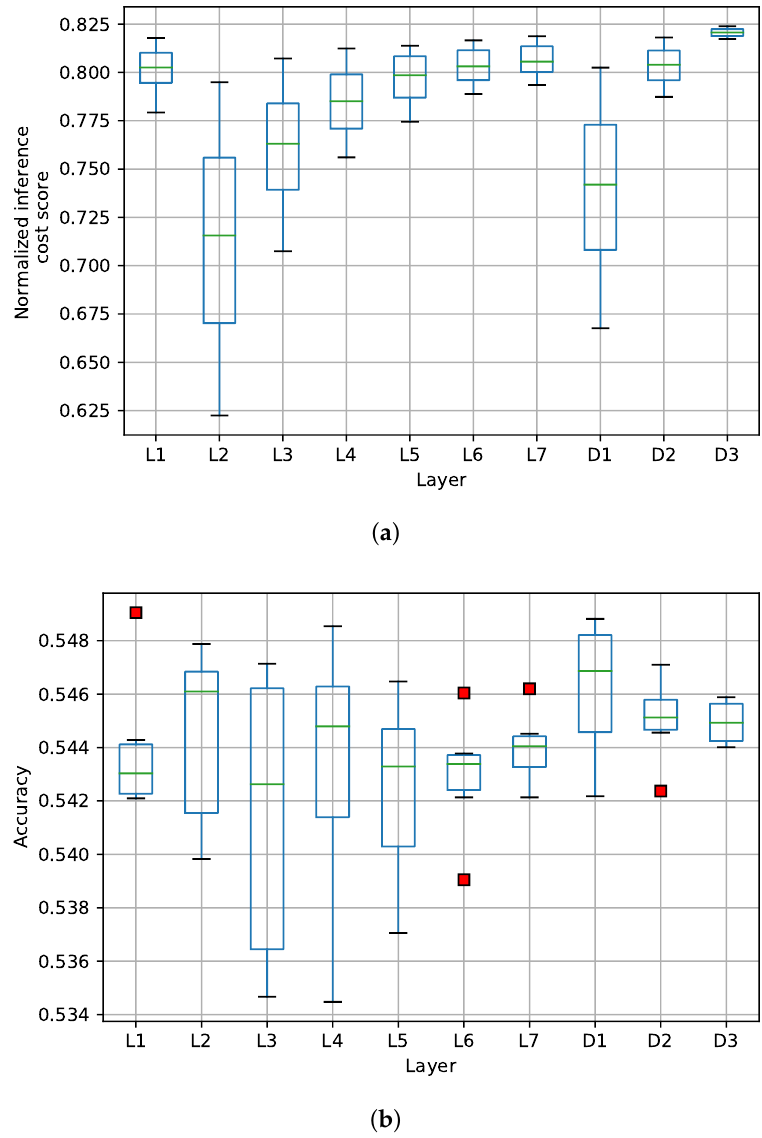
Figure 5. Impact of quantization applied in the VGG10 1D-CNN architecture proposed by [37] used in the classification of communication signals. Panel ( a ) shows the effect of the reduction in computational cost observed in each CNN layer. Panel ( b ) shows the accuracy observed at each layer. In this case, the red dots indicate outlier accuracy values corresponding to configurations with a high degree of